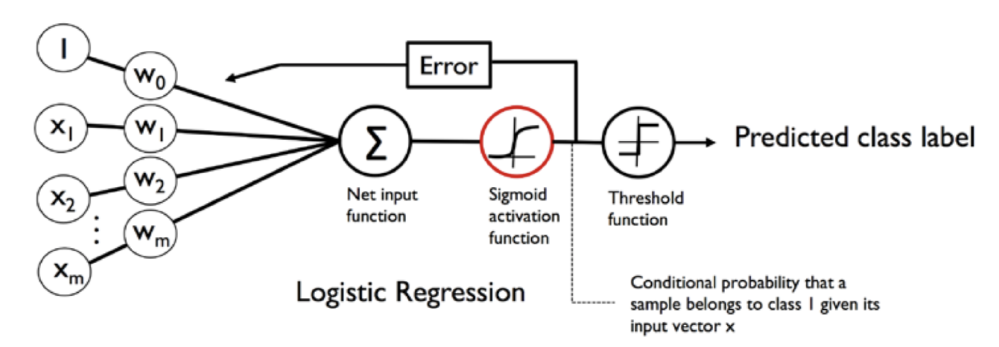
Figure 6. Architecture of a Logistic Regression Model